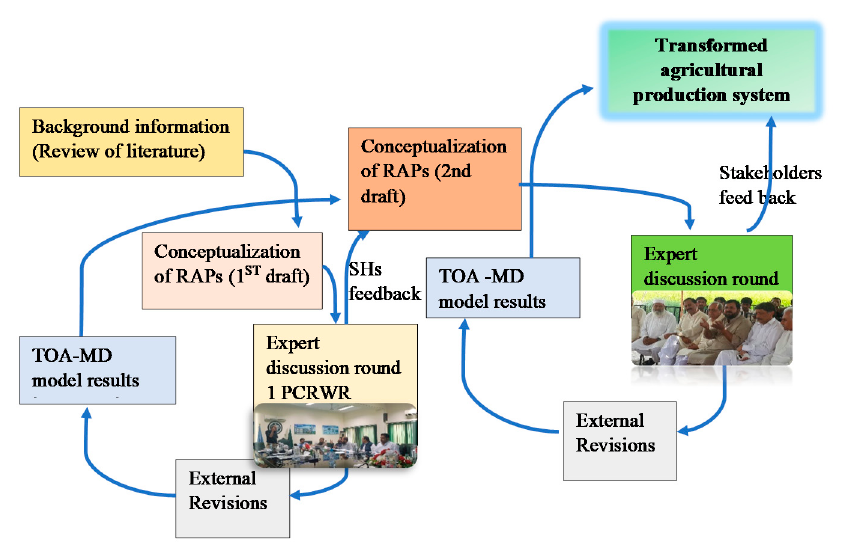
Figure 4. Transformative adaptations and RAP development process, which includes three consultative sessions at the Pakistan Council of Research in Water Resources, study area and UAF. Adopted from [29].